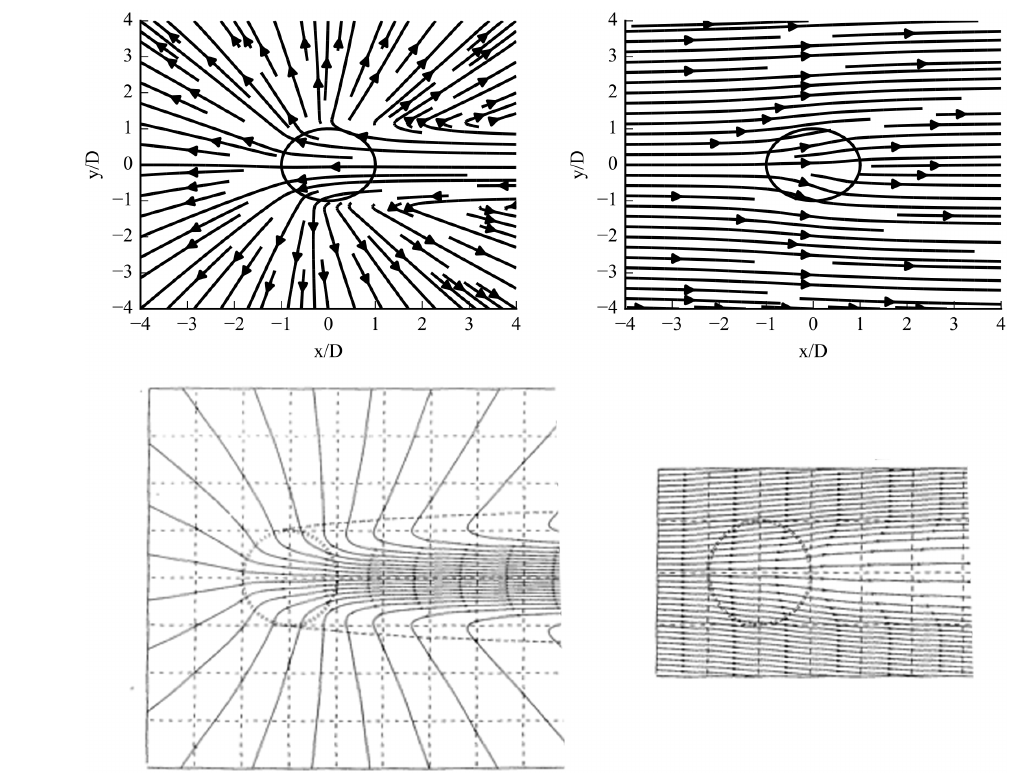
Figure 17. The top row is for the linear actuator cylinder theory, showing streamlines for an isolated turbine. The left panel shows the induced velocity only, while the right panel includes the freestream. The bottom row shows the same conditions, but with the full Euler equations (Madsen,